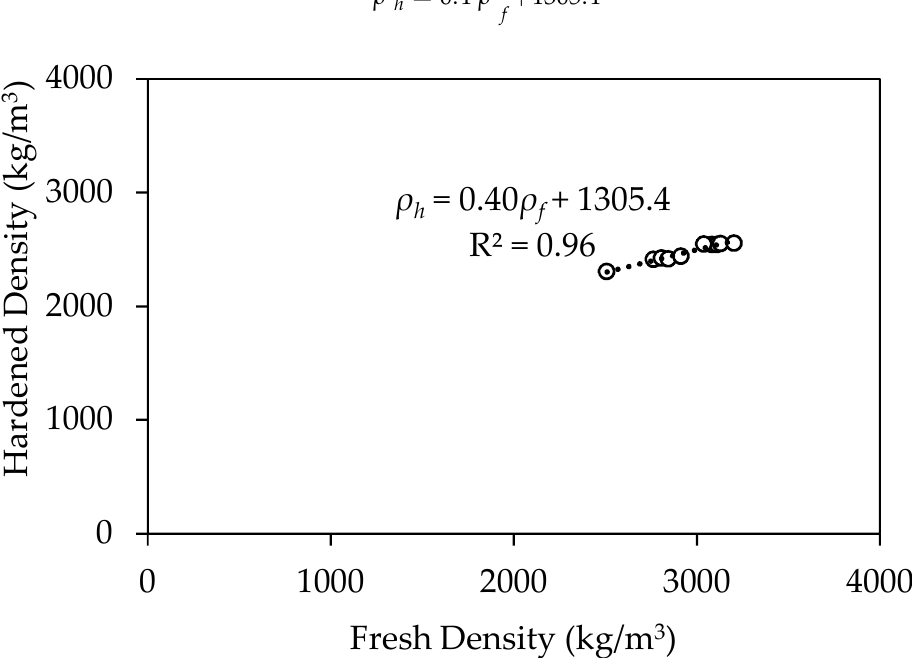
Figure 8. Relationship between fresh and hardened densities.